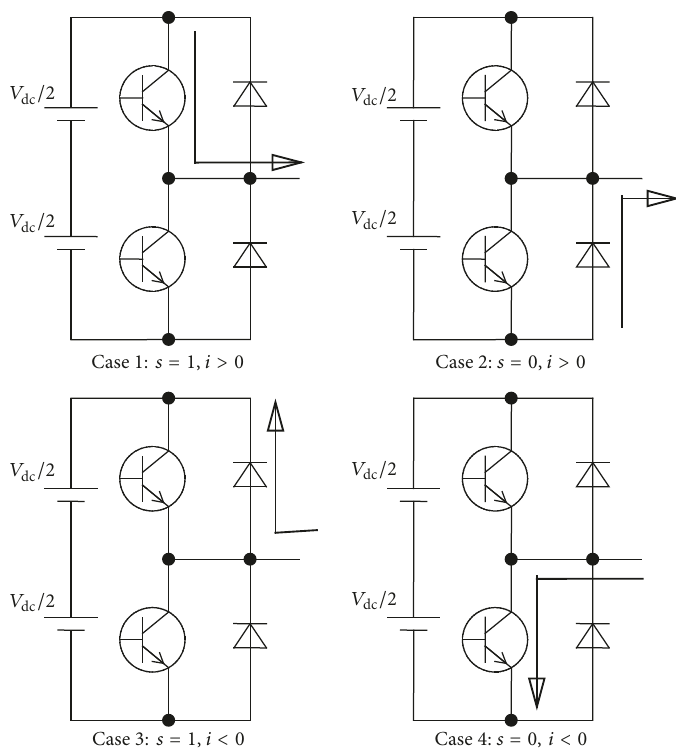
Figure 19: Analysis of the output voltage of a phase inverter